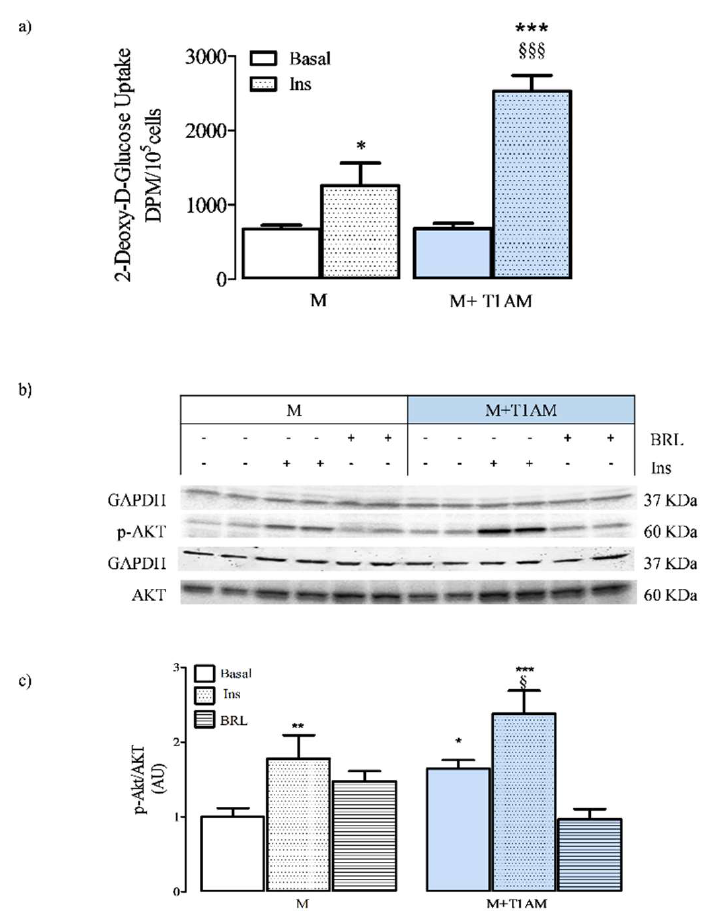
Figure 5. The insulin-stimulated glucose uptake in M + T1AM and M cells: the e ff ect at the AKT activation. The radiochemical determination of basal and insulin-stimulated glucose uptake in M and M + T1AM was carried out as described in the Materials and Methods. ( a ) Results on the histogram represent the mean ± standard error of the mean (SEM) of the radioactivity, expressed as DPM / 10 5 cells, recovered in cells from three di ff erent preparations with each point run in triplicate (* p < 0.05 and *** p < 0.01 vs. basal release of M cells; §§§ p < 0.001 vs. insulin e ff ect in M cells). M and M + T1AM cells were also analyzed to determine the p-AKT / AKT at basal and after insulin exposure conditions, as described in the Materials and Methods. ( b ) A representative experiment is shown. The gel was loaded with proteins derived from two di ff erent cell preparations ( c ). The densitometric analysis of p-AKT / AKT in M and M + T1AM cells is reported as arbitrary units (AU, see the Methods). Results on the histogram represent the mean ± standard error of the mean (SEM; n = 4 cell preparations) of AU (see Methods; * p < 0.05, ** p < 0.01, *** p < 0.001 vs. basal M cells; § p < 0.05 vs. basal M + T1AM cells).